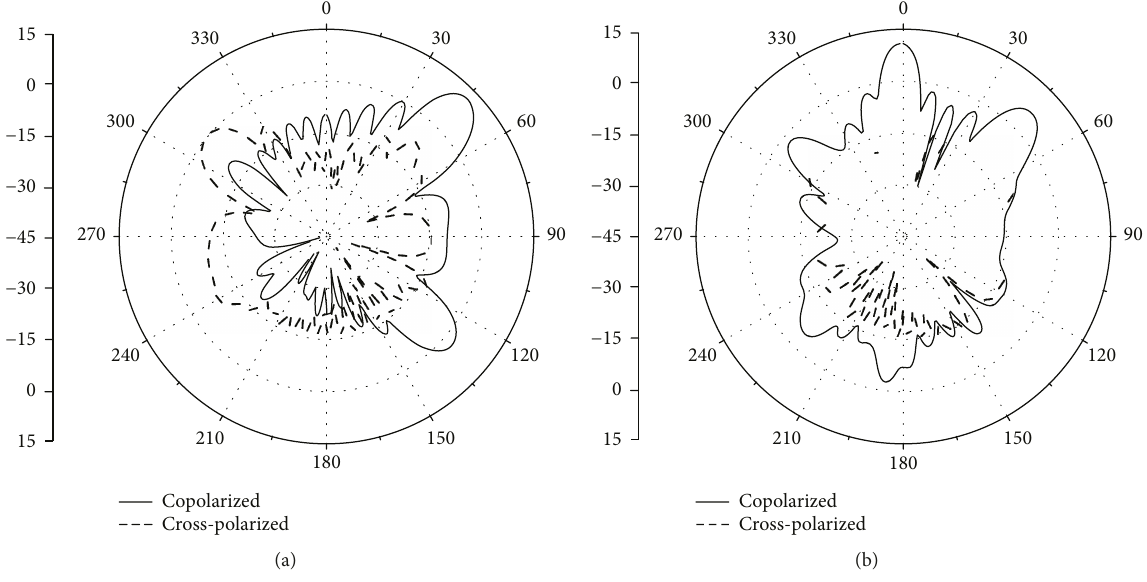
Figure 11: Simulated radiation patterns of the antenna arrays: (a) Con fi guration 1; (b) Con fi guration 2.